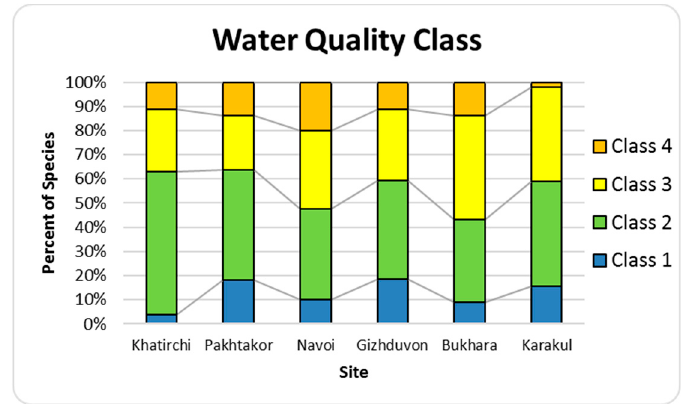
Figure 6. Distribution of bioindicators of water quality on the base of species-specific indices of organic pollution according Sláde č ec in the Zarafshan River, 2009–2015. Legend: Class of Water Quality 1–5. Table 3. Percent of bioindicator groups in each studied site community of the Zarafshan River, 2009–2015. The ecological groups’ order in respect of each group indicator value increasing.